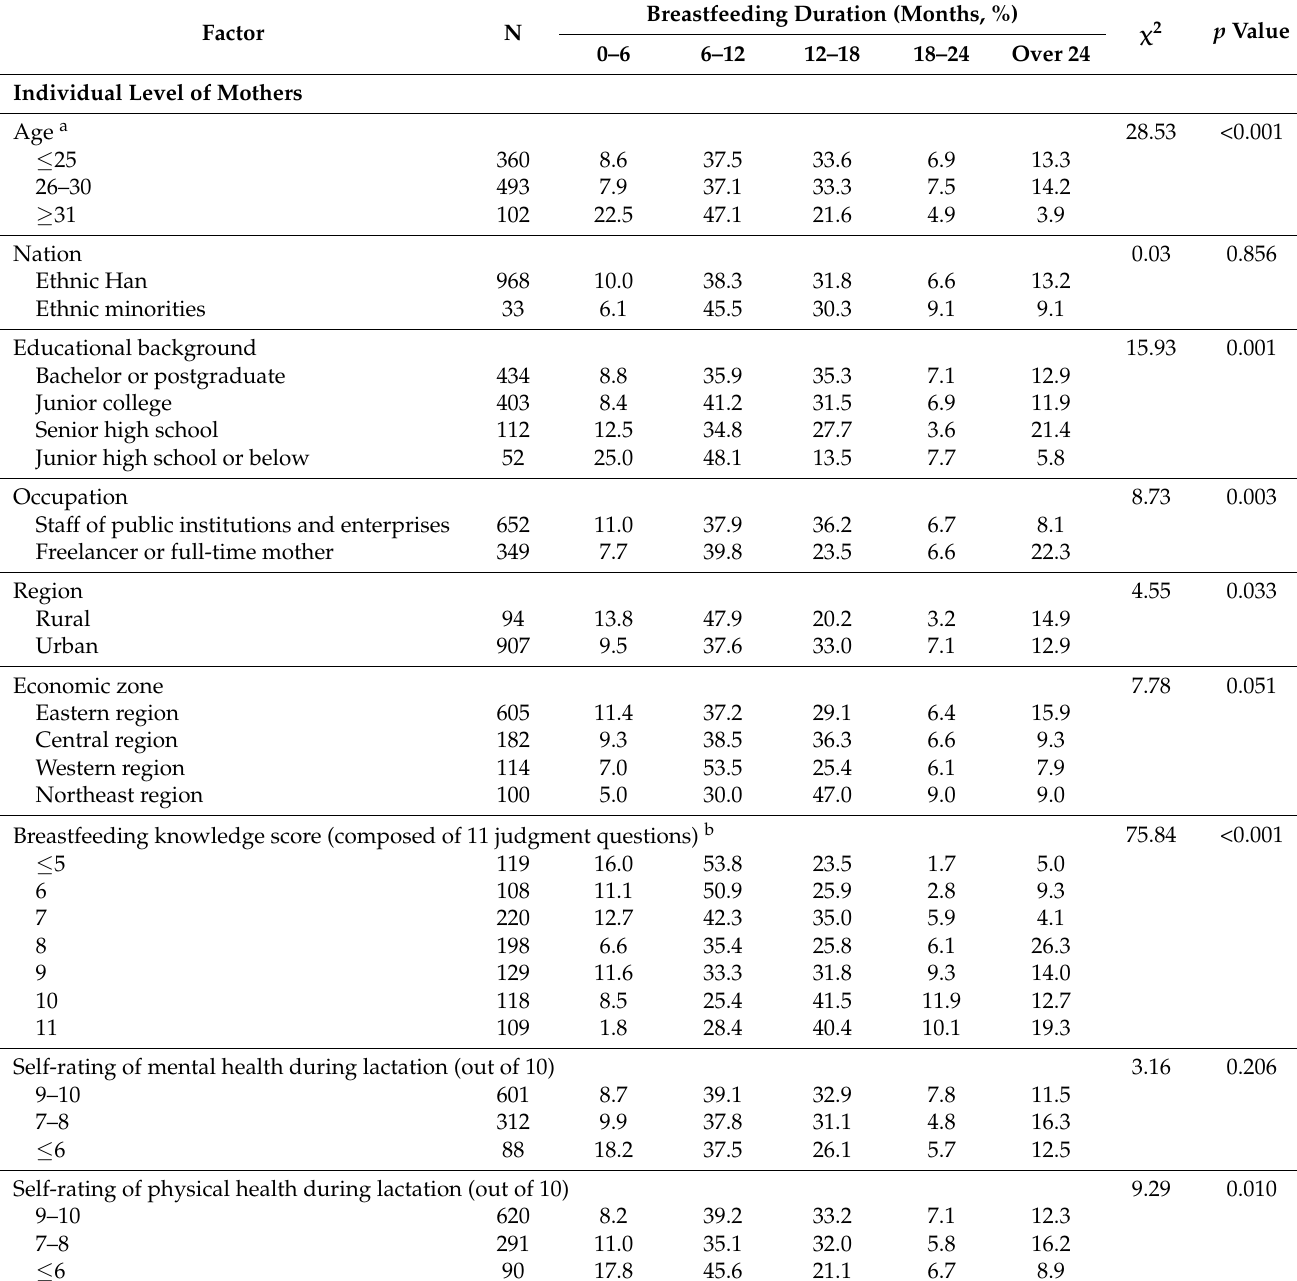
Table 1. Respondent characteristics ( n = 1001) and single factor analysis of influencing factors on breastfeeding